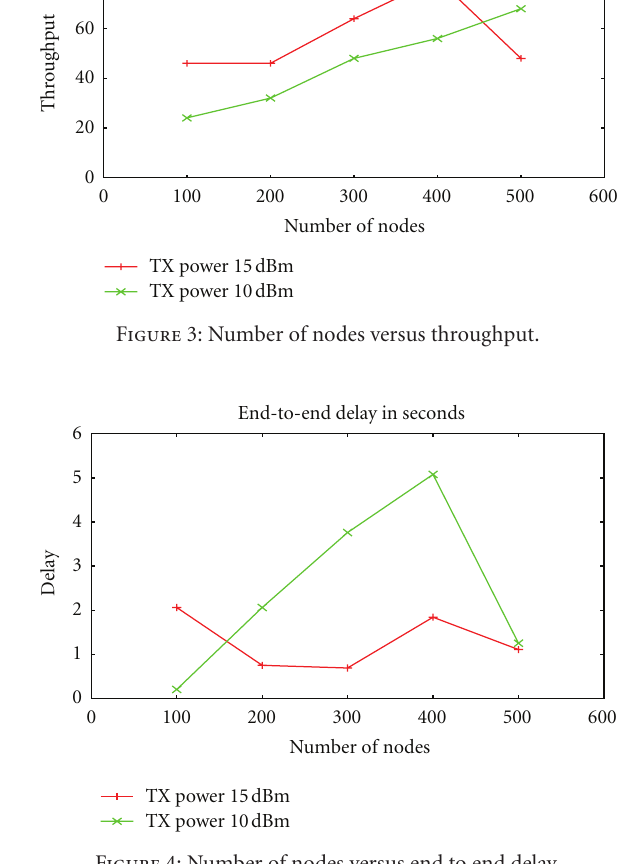
Figure 4: Number of nodes versus end to end